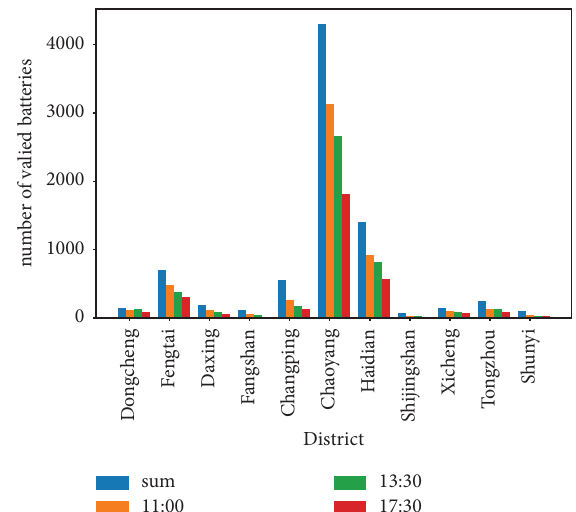
Figure 4: Te utilization rate of BSS in Beijing during the peak